Question: According to the figure, is the described quantity increasing or decreasing?
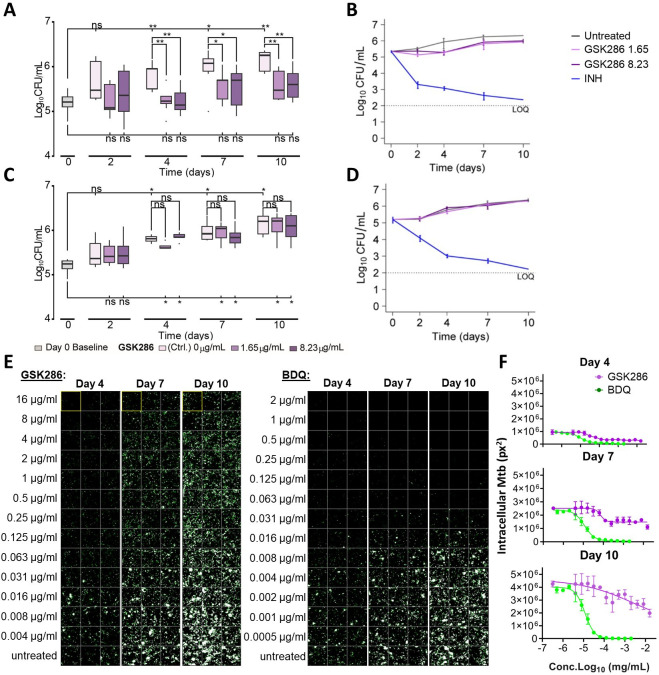
Answer: increasing